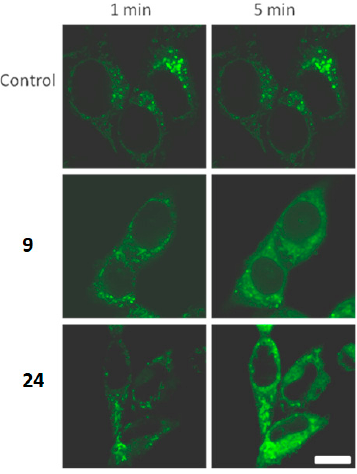
8 of 18 Figure 3. Cytoplasmic distribution of compounds 9 and 24 . The HCT116 cells were loaded with 9